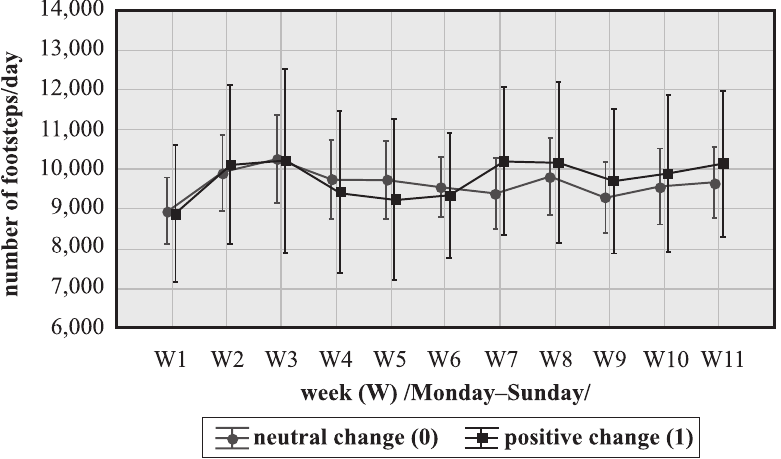
Figure 1. Average physical activity (number of footsteps/week) according to women’s categories in relation to the positive or without